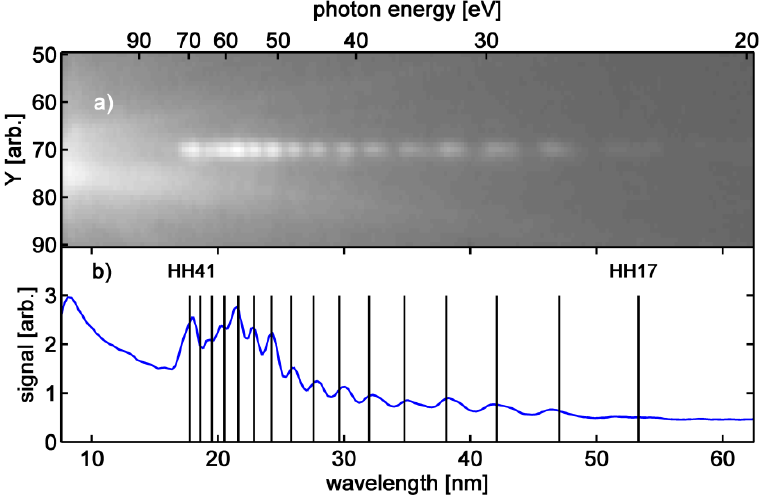
Figure 2. ( a ) Diffracted signal from the permanent grating on a logarithmic gray scale. The x axis is calibrated in terms of wavelength, the y axis is the orthogonal dimension of the CCD chip. Different odd harmonics of the 800 nm Ti:Sapph laser can be clearly distinguished. The background at short wavelength is due to scattering of zero order light; ( b ) Integration of the signal shown in (a) over a window of around the spectral trace. The predicted position of the different odd harmonics from order 17 to 41 was used to calibrate the